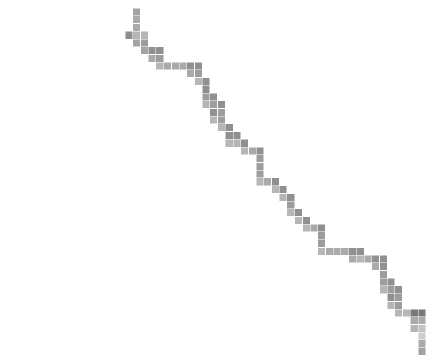
Fig. 8: Random parallelogram and convex polyominoes of perimeter